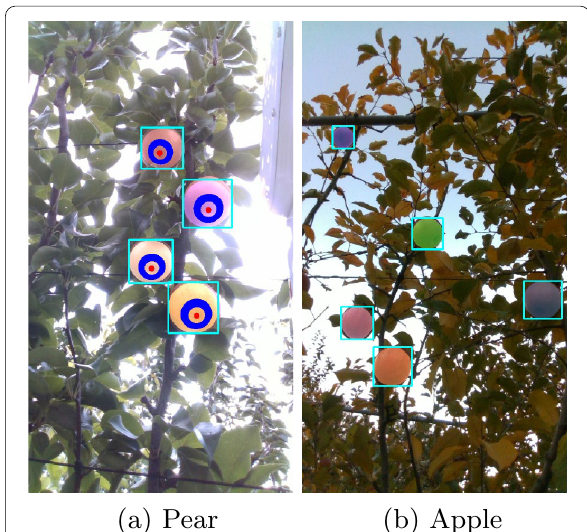
Fig. 11 Recognition results on the 2D images